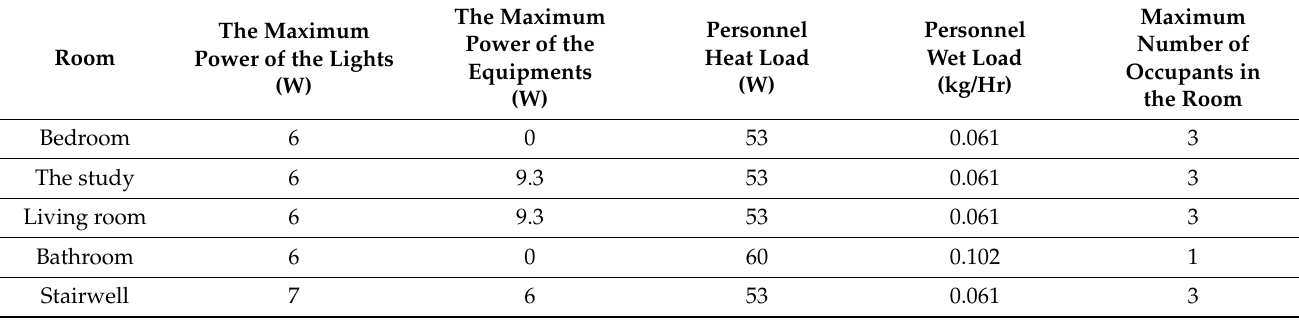
Table A2. Parameter setting of room thermal disturbance.